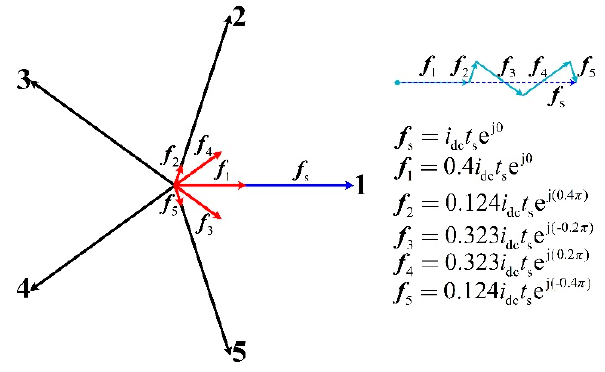
Figure 2. The synthesized vector and the impulse current vector’s distribution. According to the feature of the current source inverter, a current path needs to be maintained at any time; that is, one upper semiconductor switch and one lower semicon- ductor switch need to be turned on at any time. Therefore, during one switching cycle, there are two different cases. One is named the zero impulse current area, and the other is named the active impulse current area. In the zero impulse current area, both the upper and lower semiconductors of one phase need to be turned on simultaneously, which are selected by the principle of the minimal switching number. In the active impulse current area, one positive impulse current vector duty and one negative duty need to be selected, and the corresponding semiconductors need to be turned on. According to the magni- tude relationship and the polarity conditions of the five-phase impulse current duties, the action order can be determined by sorting these duties from large to small, and then the PWM waveform can be generated. For example, when the duties are D 1 = 0.4, D 2 = 0.124, D 3 = − 0.323, D 4 = − 0.323, D 5 = 0.124, the action order of the five-phase impulse current duties can be shown in Figure 3.